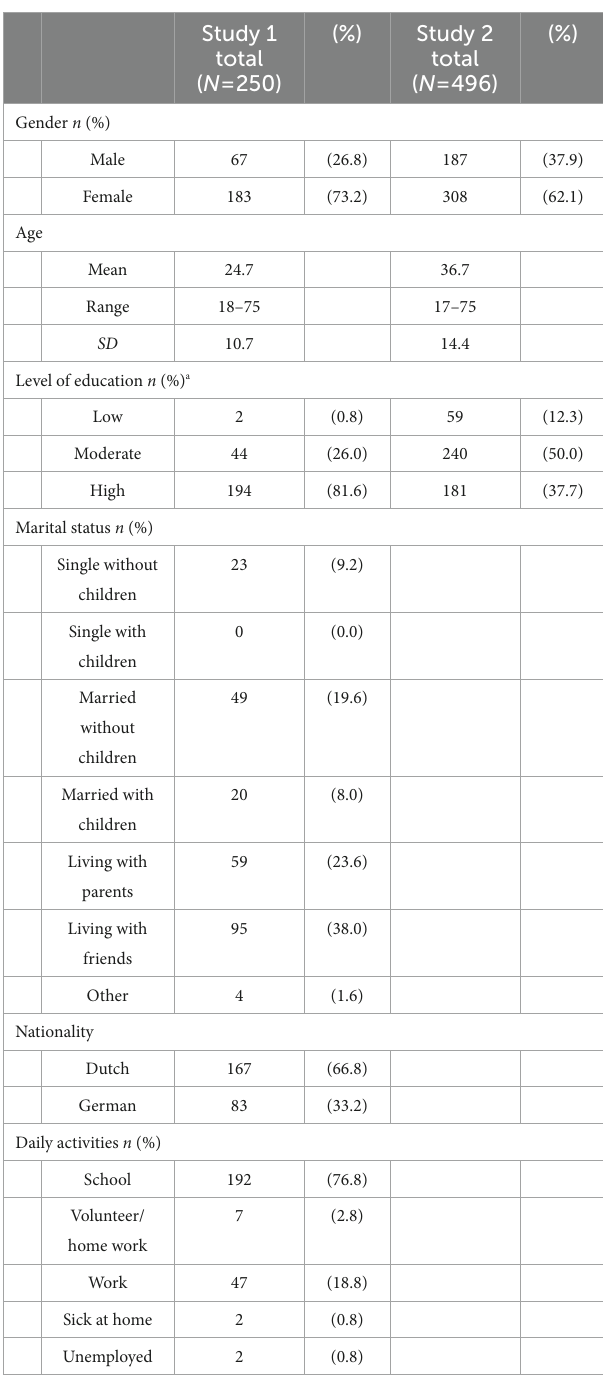
TABLE 1 Major characteristics of respondents.